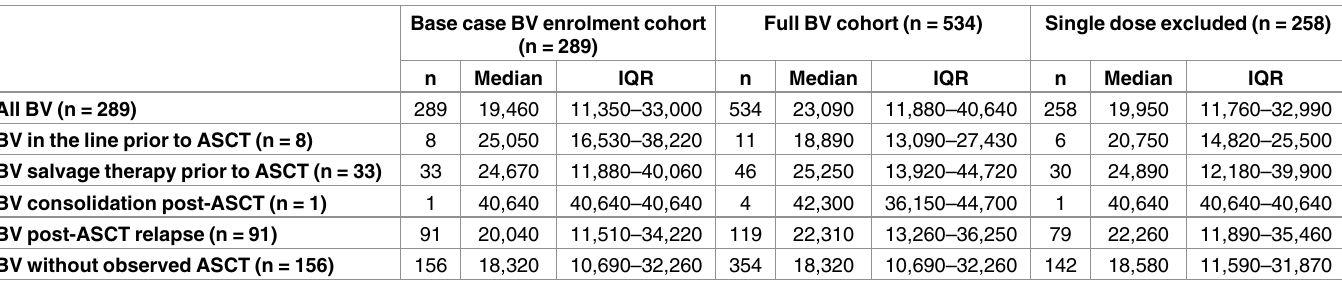
Table 5. Median (IQR) monthly costs (USD), under the base case, and for each of the sensitivity and subgroup analysis scenarios. Base case BV enrolment cohort (n =